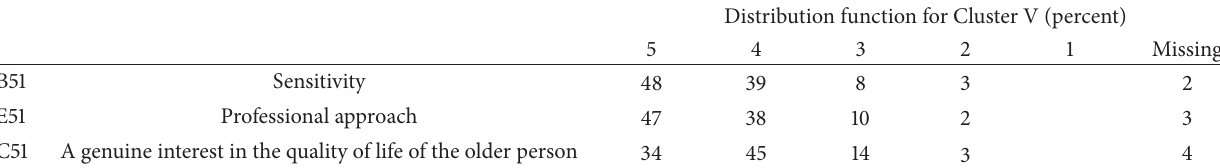
Table 7: Cluster V: Possibilities for closeness and distance.